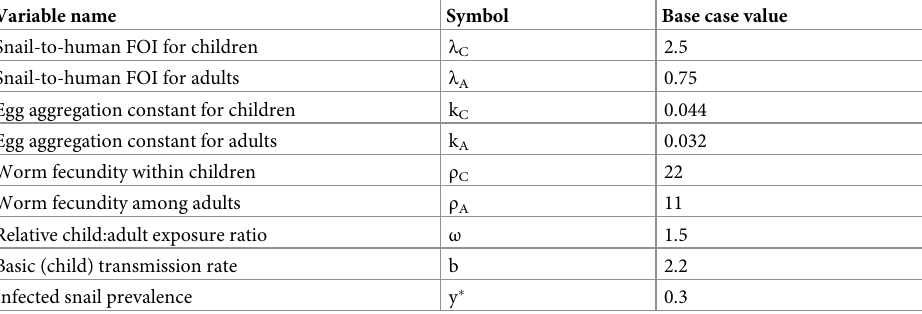
Table 3. Parameters used in long term MDA simulation of a high-risk